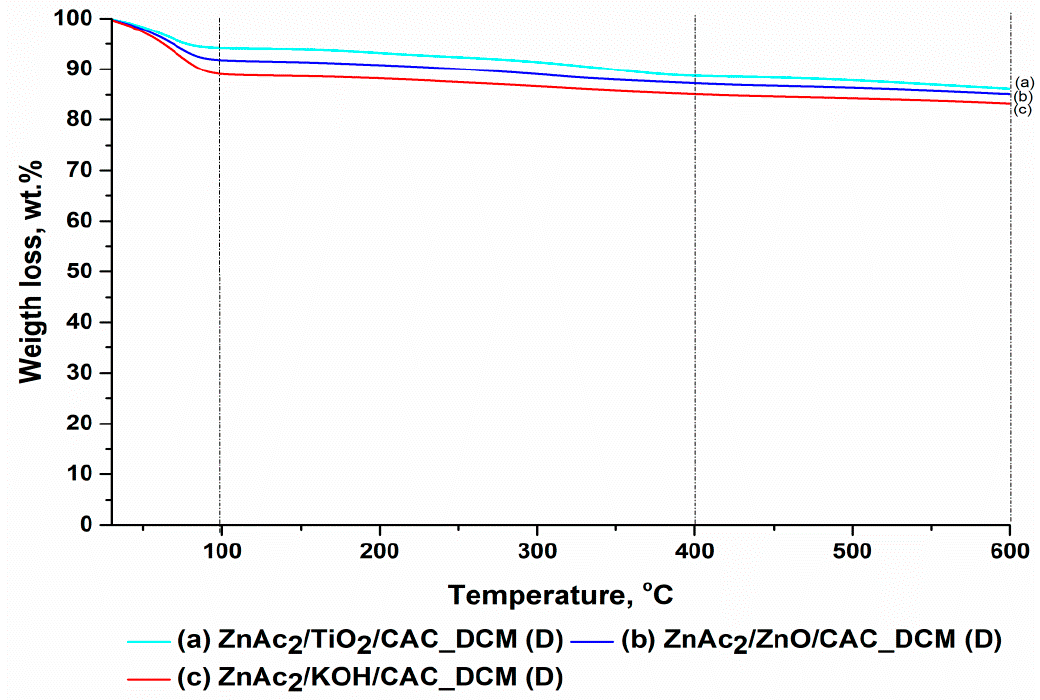
Figure 11. TGA profiles for exhausted DCM/CAC adsorbents. Table 8. Comparison of weight losses (%) with temperature derivatives in TGA for fresh and ex- hausted DCM/CAC